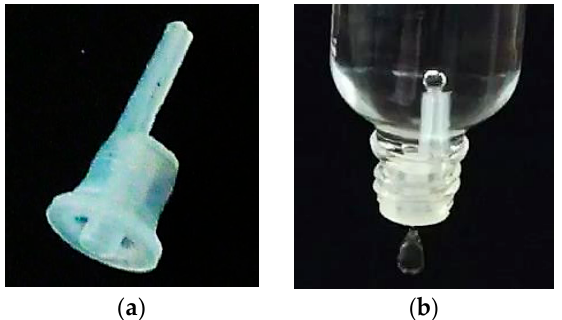
Figure 1. ( a ) shows the droplet dosing device ‘Senkrechttropfer S2 0,6’ from ‘POMPL direkt e.K’. ( b ) shows this device combined with a bottle with a nominal volume of 50 mL. In the moment the picture was taken a droplet is detaching below the device and a bubble is forming on top of the ventilation capillary inside the